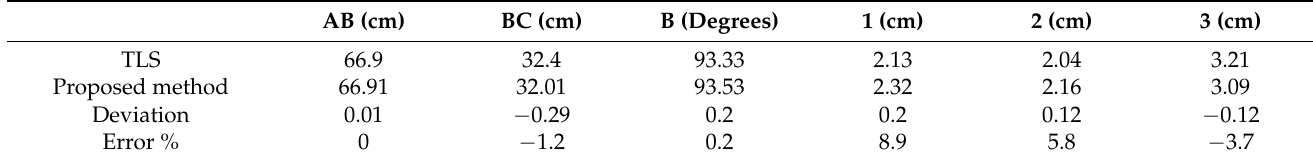
Table 8. Measurement carried out on both point clouds generated by TLS and the proposed